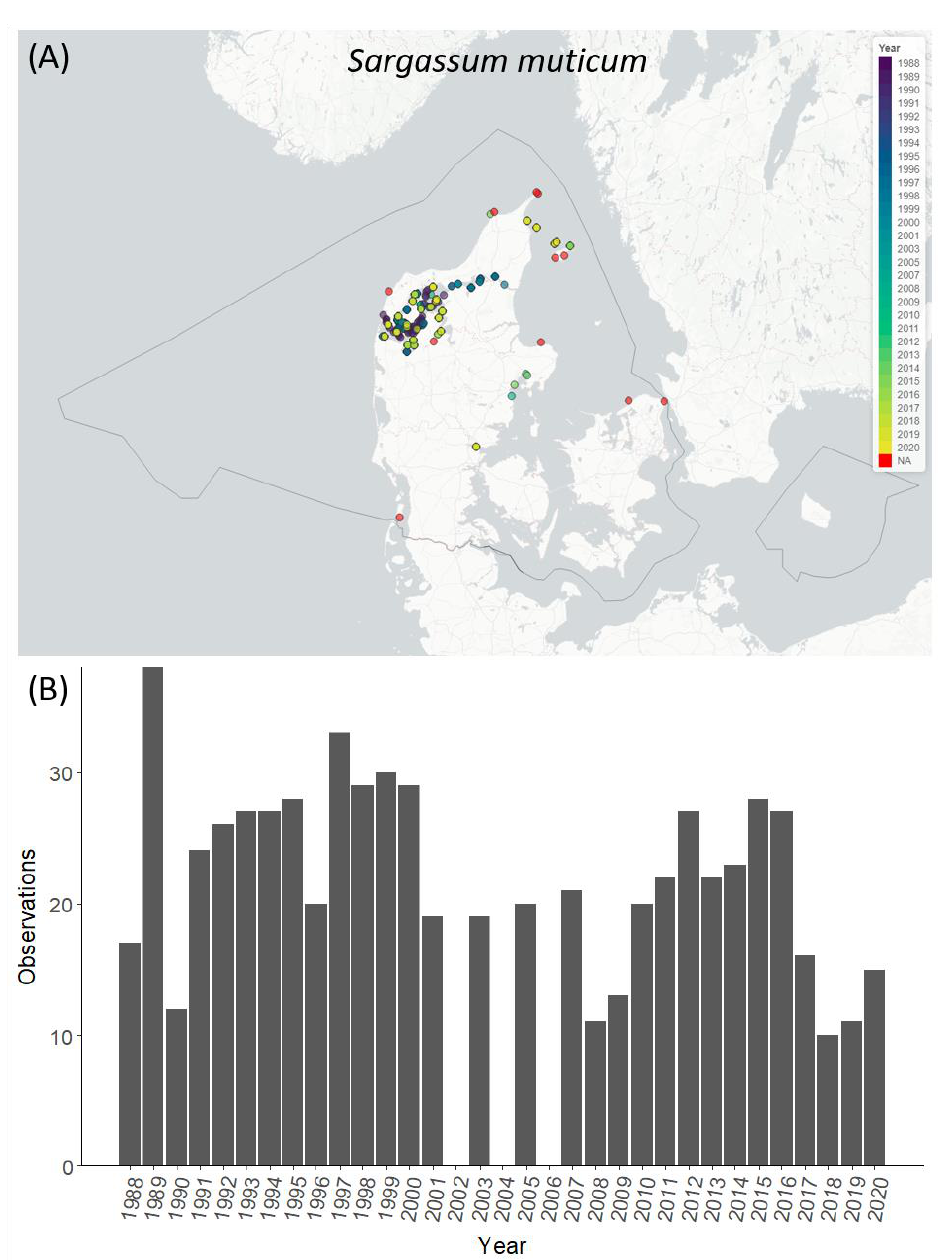
Figure 17. Distribution of Sargassum muticum in Danish waters ( A ); number of observations during the years 1988–2020 from the NOVANA database and from Nielsen et al. [62] ( B ). The red dots in ( A ) are records that are not included in ( B